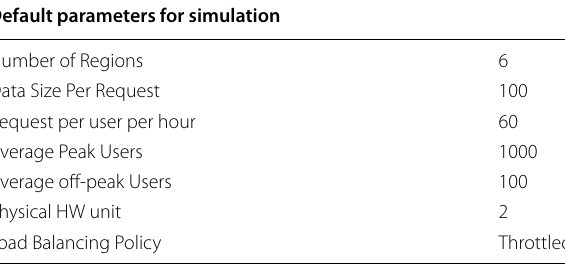
Table 3 Default parameters for simulation Default parameters for simulation